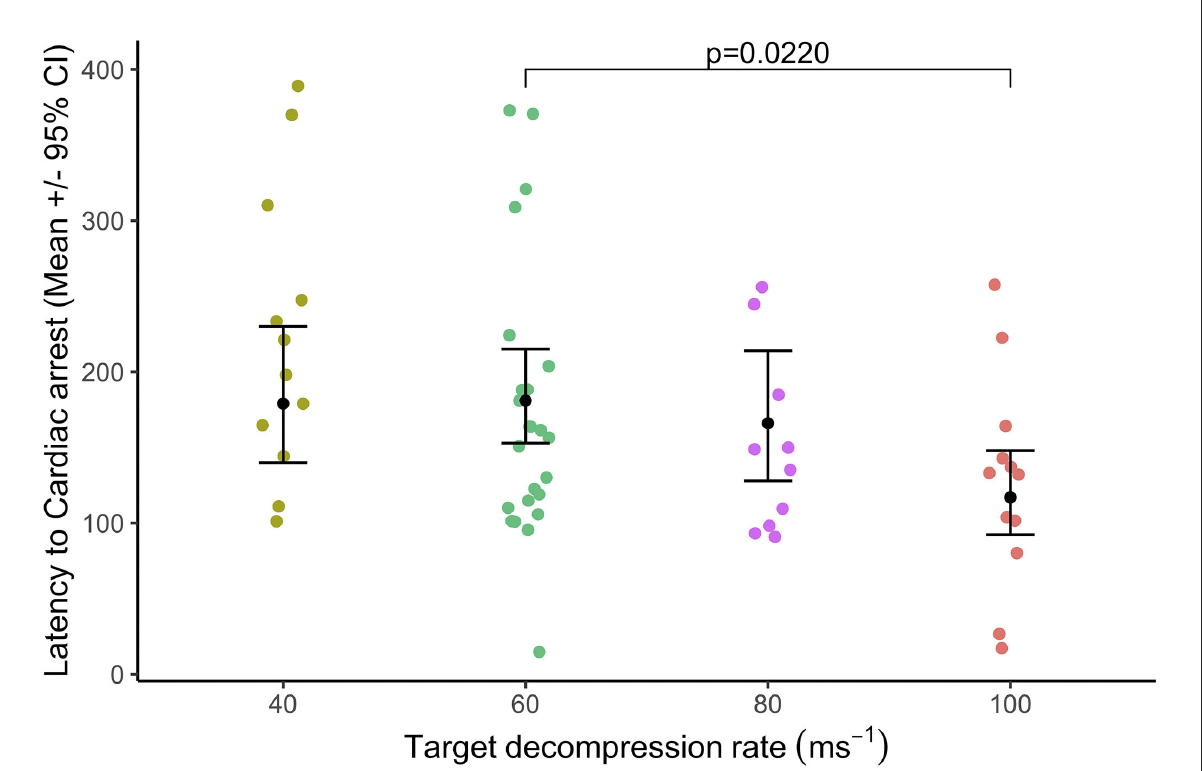
FIGURE6 Mean ( ± 95% CIs) latency to cardiac arrest relative to target decompression cycle rates: 40 ms − 1 ( n = 12), 60 ms − 1 ( n = 24), 80 ms − 1 ( n = 10), or 100 ms − 1 ( n = 12). Cardiac arrest was defined by permanent loss of mechanical cardiac activity, represented by the time at which the pulse volume contour on the pulse plethysmograph became permanently imperceptible. Significant pairwise comparisons are annotated